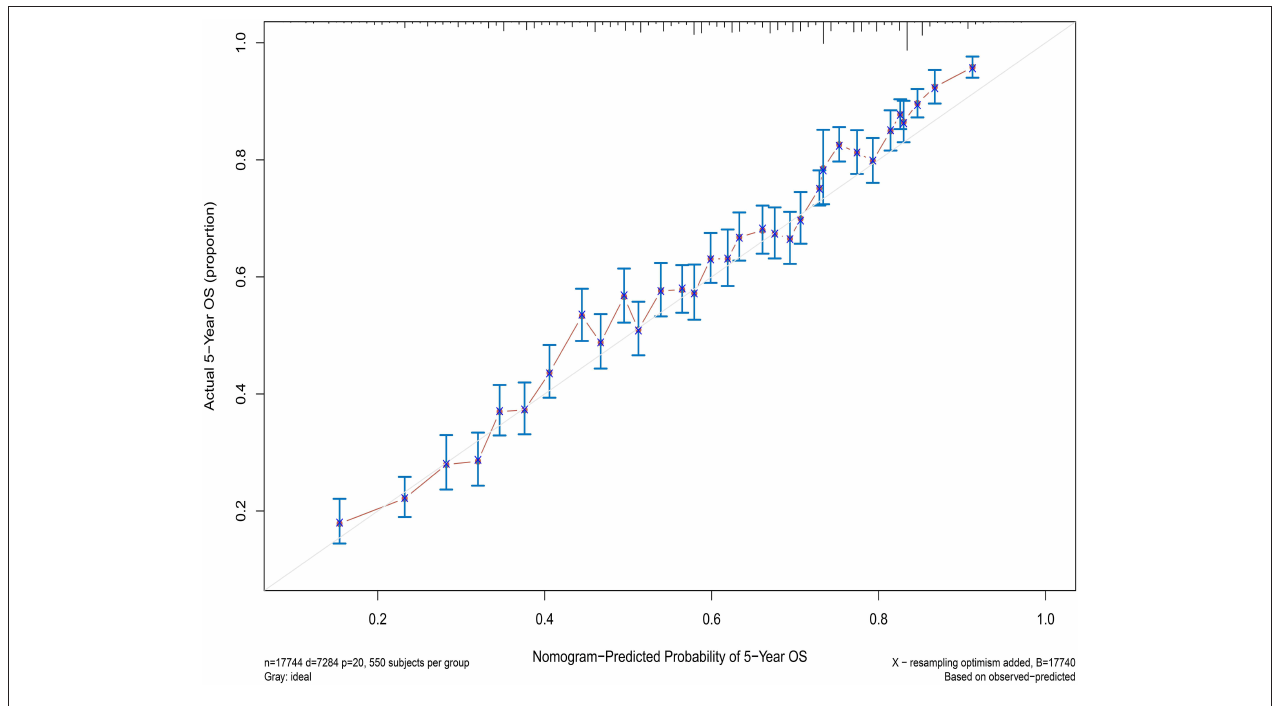
FIGURE 10 | The calibration curves for predictions of overall survival at 5 years after diagnosis.